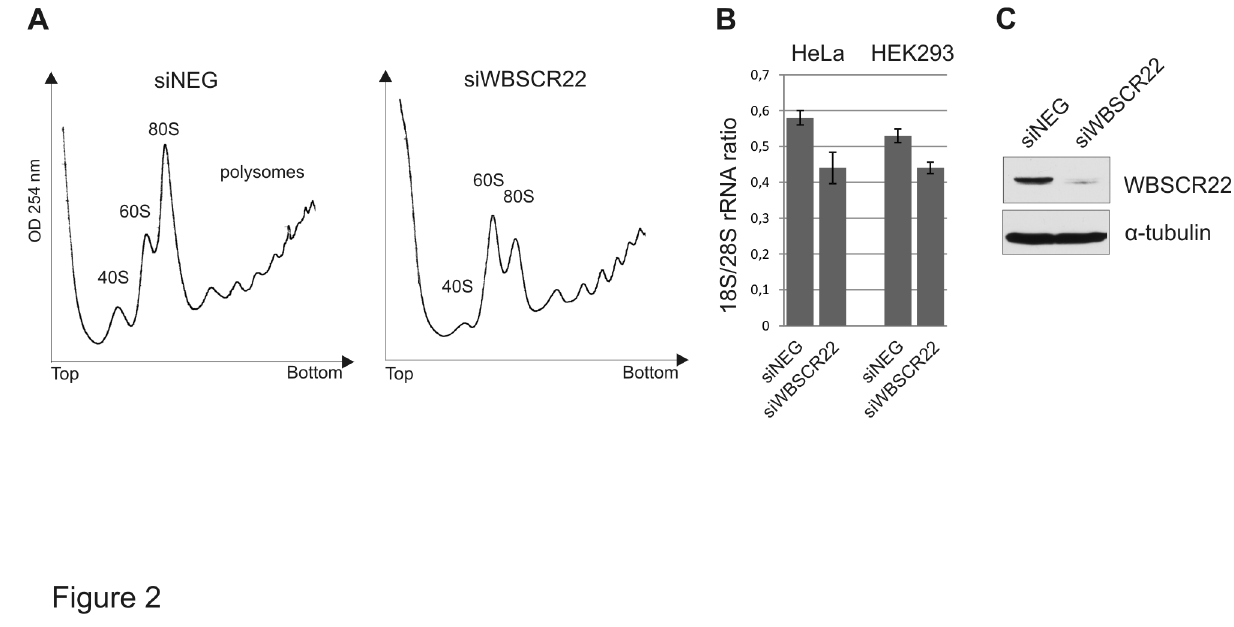
Figure 2. Polysome analysis of HeLa cells after depletion of WBSCR22. (A) HeLa cells were transfected with siWBSCR22 and siNeg, the cytoplasmic cell extracts were prepared 72 h after transfection and centrifuged on 10-50% sucrose gradient. Absorbance at 254 nm was measured across the gradient, and the positions corresponding to the 40S, 60S and 80S ribosomal particles are indicated. (B) The ratio of 18S/28S rRNA from HeLa and HEK293 cells transfected with siRNAs. RNA was purified from cytoplasmic extracts of siWBSCR22 and siNeg cells, separated by electrophoresis and intensities of 18S and 28S rRNA were quantified. The P value is 0.04 using Student’s t-test. (C) Protein expression of siWBSCR22 and siNeg. transfected cells was determined by western blot analysis using anti-WBSCR22 and anti-tubulin